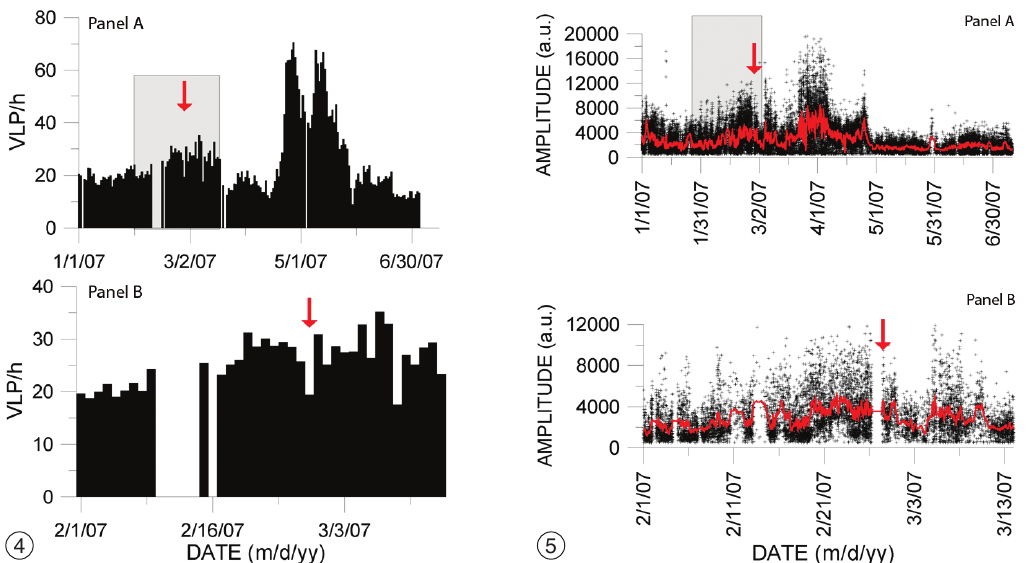
Fig. 4. VLP hourly frequency from January 1, 2007 to July 10, 2007 (panel A). The red arrow marks the onset of the effusive eruption. Panel B shows the VLP hourly frequency in the time window (February 1-March 14, 2007) marked by the gray rectangle in the panel A. Fig. 5. VLP amplitude versus time (STR1) for the period from January 1, 2007 to July 10, 2007 (panel A). The solid red line shows the running average calculated on a 41-point window. The red arrow marks the onset of the effusive eruption. Panel B shows the VLP amplitude in the time window (February 1-March 14, 2007) marked by the gray rectangle in the panel A.